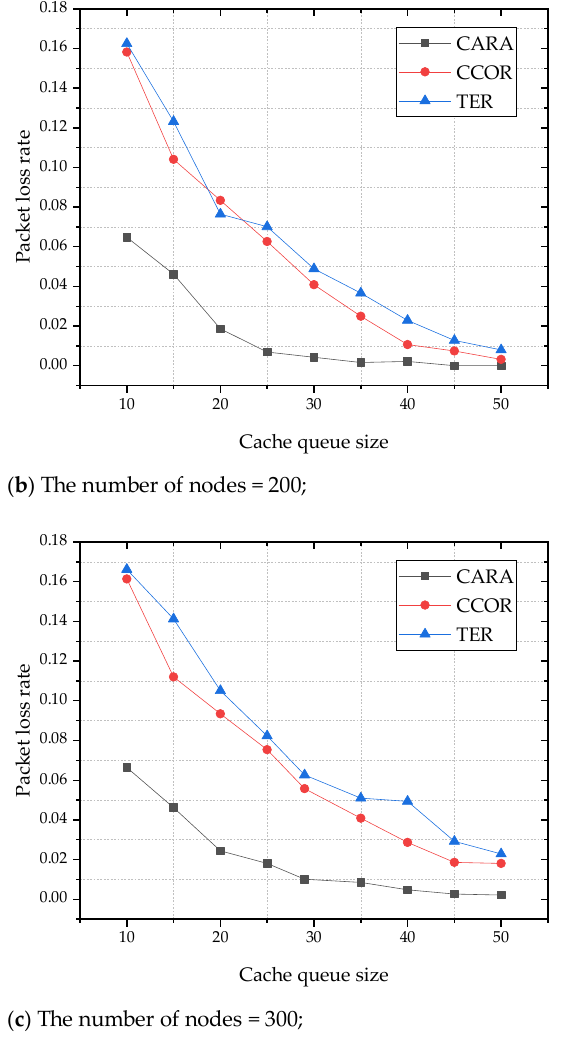
Figure 3. The packet loss rate varies with the size of the node cache. ( a ) The number of nodes = 100; ( b ) the number of nodes = 200; ( c ) the number of nodes = 300.